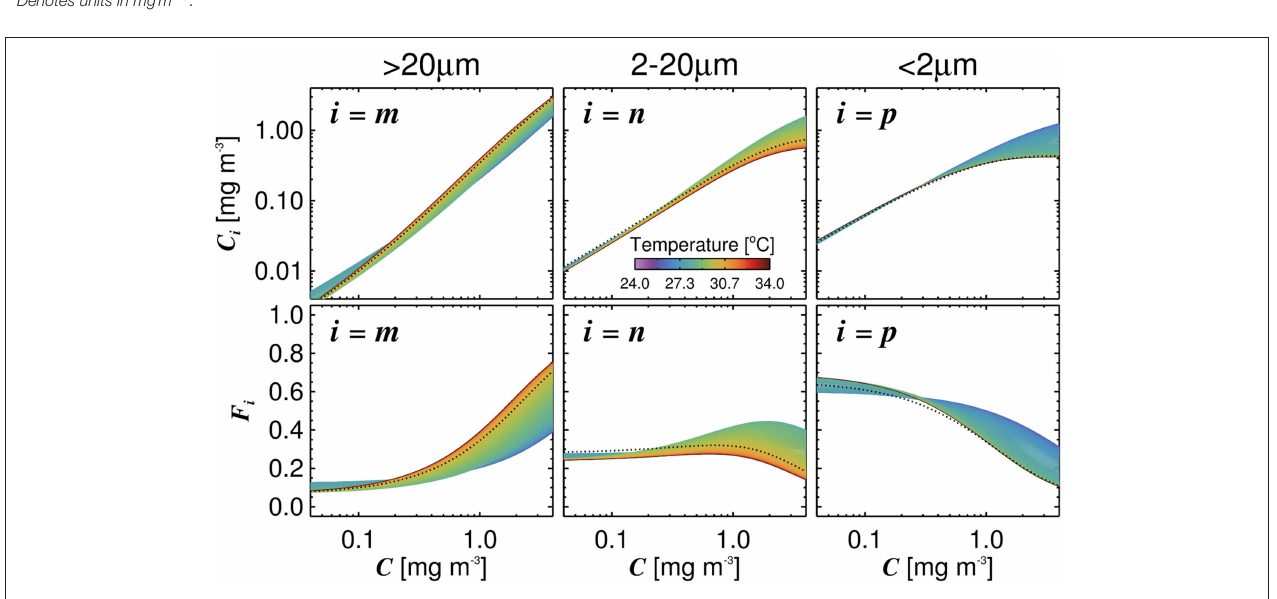
FIGURE 4 | Influence of temperature on the relationship between size-fractionated chlorophyll and total chlorophyll, when incorporating Equations (5)–(8) into the three-component model. Top row shows the size-fractions of chlorophyll and bottom row the fractions of total chlorophyll in each size class, all plotted as a function of total chlorophyll. Dashed black lines refer to the model using a single set of parameters ( Table 2